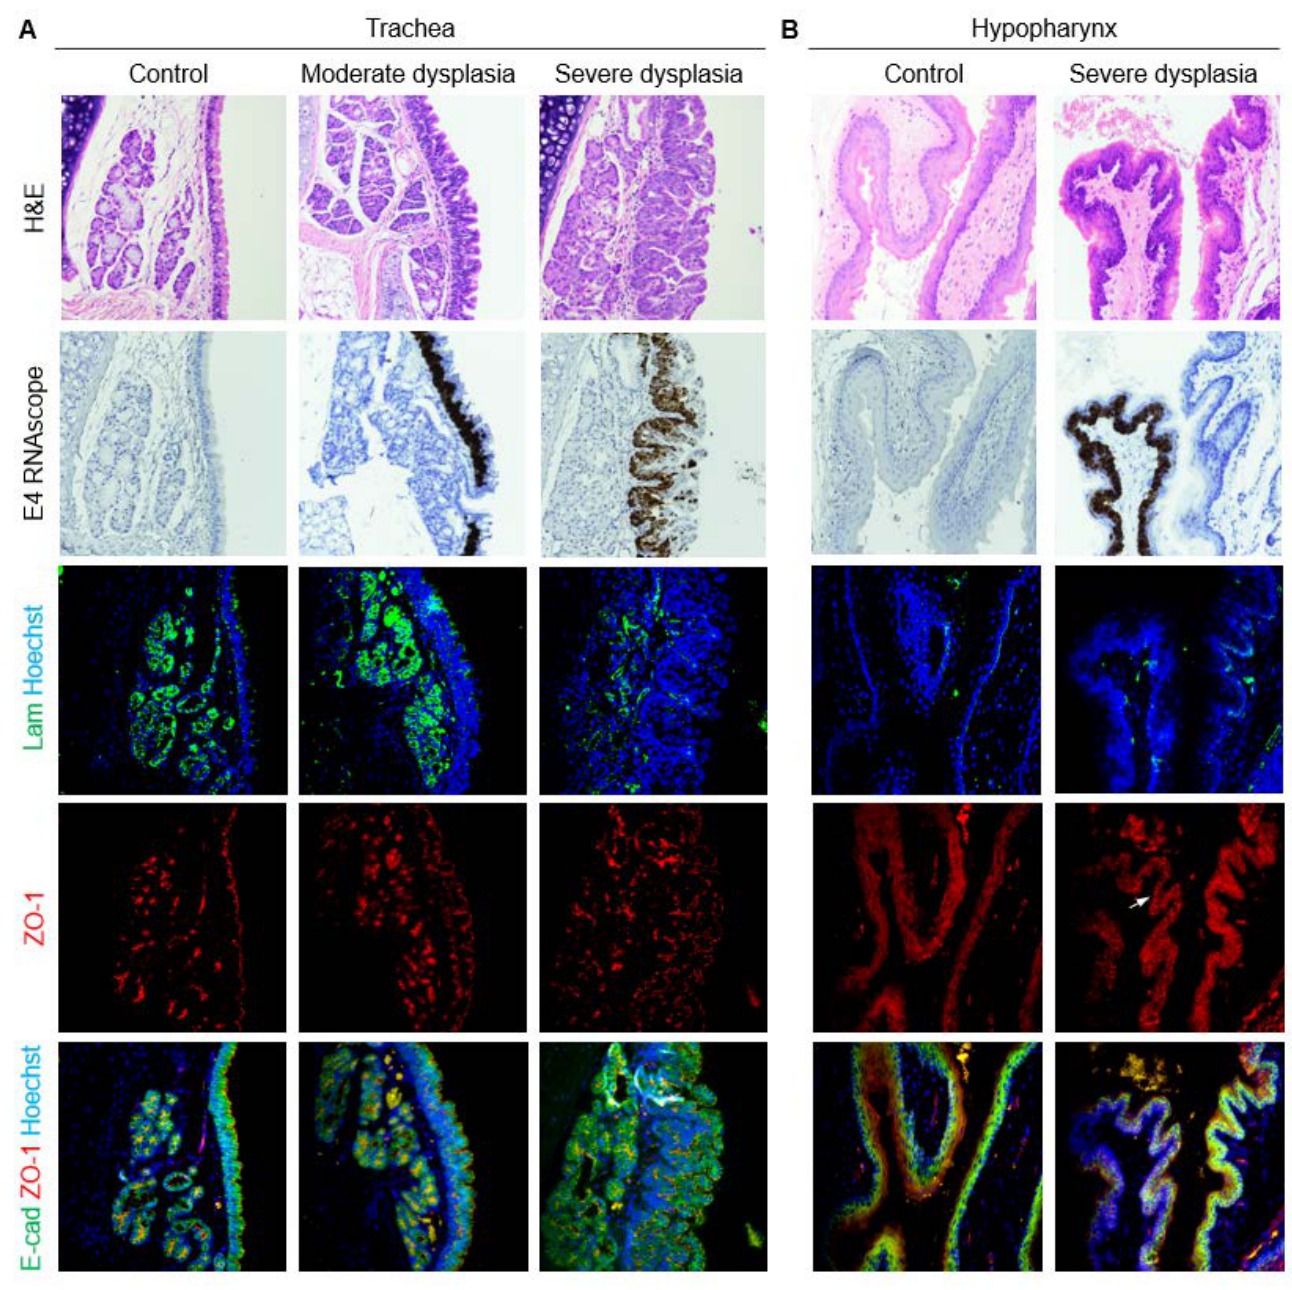
Figure 9. Perturbed epithelial barrier in trachea and hypopharynx with disease induced by MmuPV1. Serial sections of control and diseased tissues stained with H&E, MmuPV1 E4 RNAscope ISH, costained laminin (green) and Hoechst (blue) IF, and costained E-cadherin (green), ZO-1 (red), and Hoechst (blue) IF shown both in red channel and merged. 40 × magnification. Some H&E and RNAscope images reproduced with permission from our companion paper [3]. ( A ) Trachea. ( B ) Hypopharynx. Arrow: basal ZO-1 beyond cell membranes in MmuPV1-positive dysplastic epithelium.